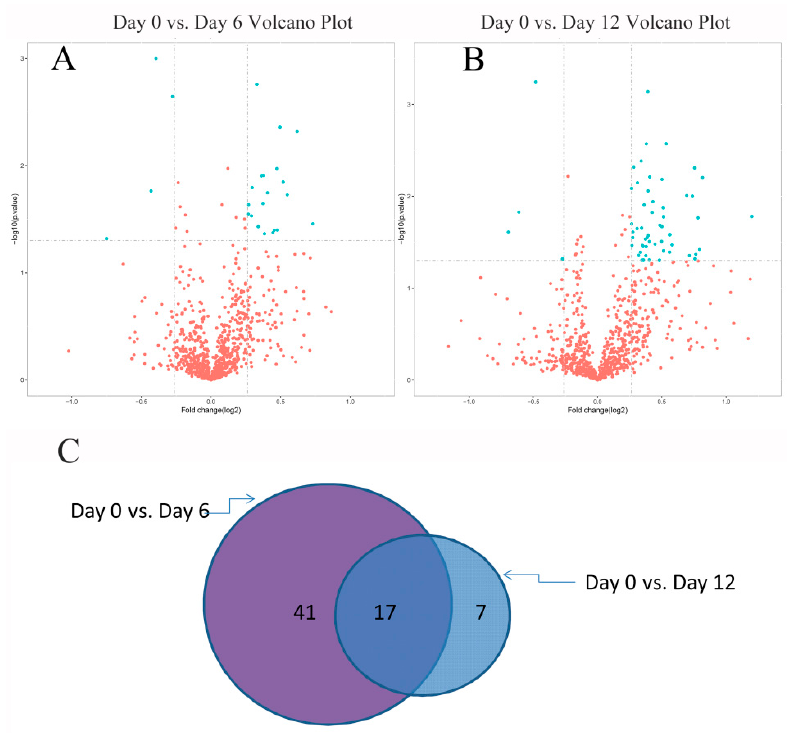
Figure 3. ( A ) Volcano plot of grouper fillets on Day 0 vs. Day 6; and ( B ) volcano plot of grouper fillets on Day 0 vs. Day 12. The abscissa is multiples for di ff erence (logarithmic transformation of 2 at the bottom), while the ordinate is significant di ff erence ( P value, logarithmic transformation of 10 at the bottom). Green Blue points indicate di ff erentially significant expressed proteins (DSEPs) (fold-change of > 1.20 or < 0.83 and p -values < 0.05). ( C ) The overlap of DSEPs from the Day 6 vs. Day 0 and Day 12 vs. Day 0 comparisons.